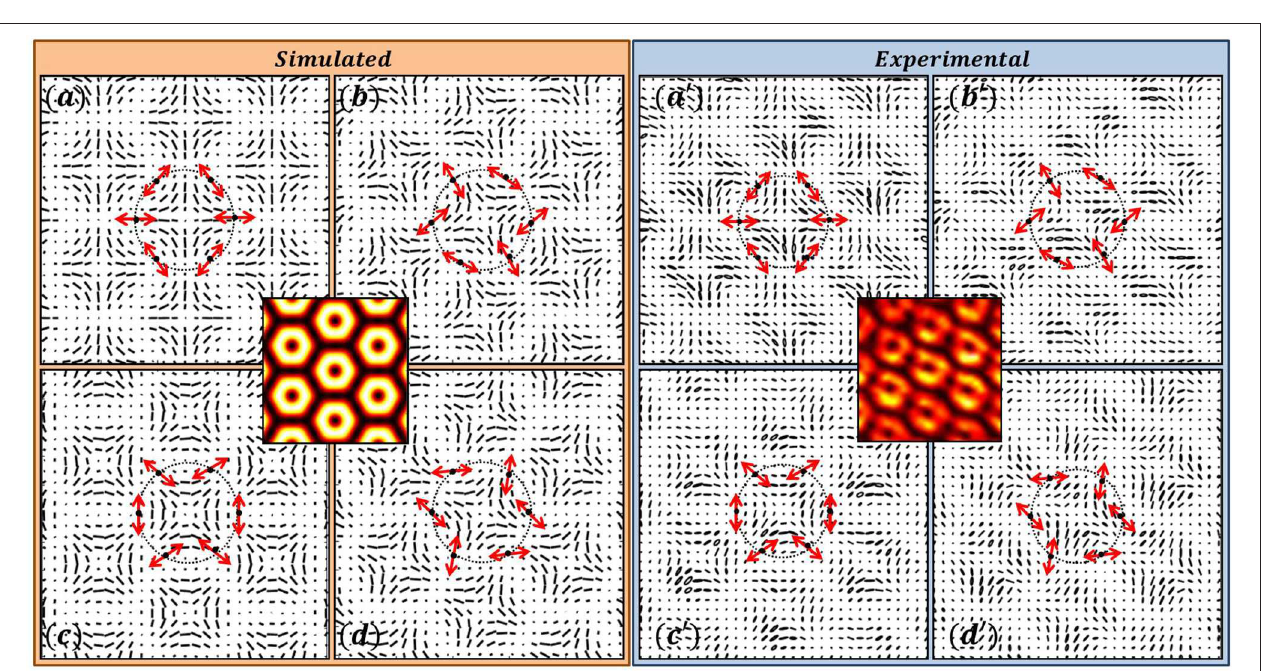
of interference of three plane waves whose SOPs are chosen from a C-point we present the simulation patterns in Figure 10